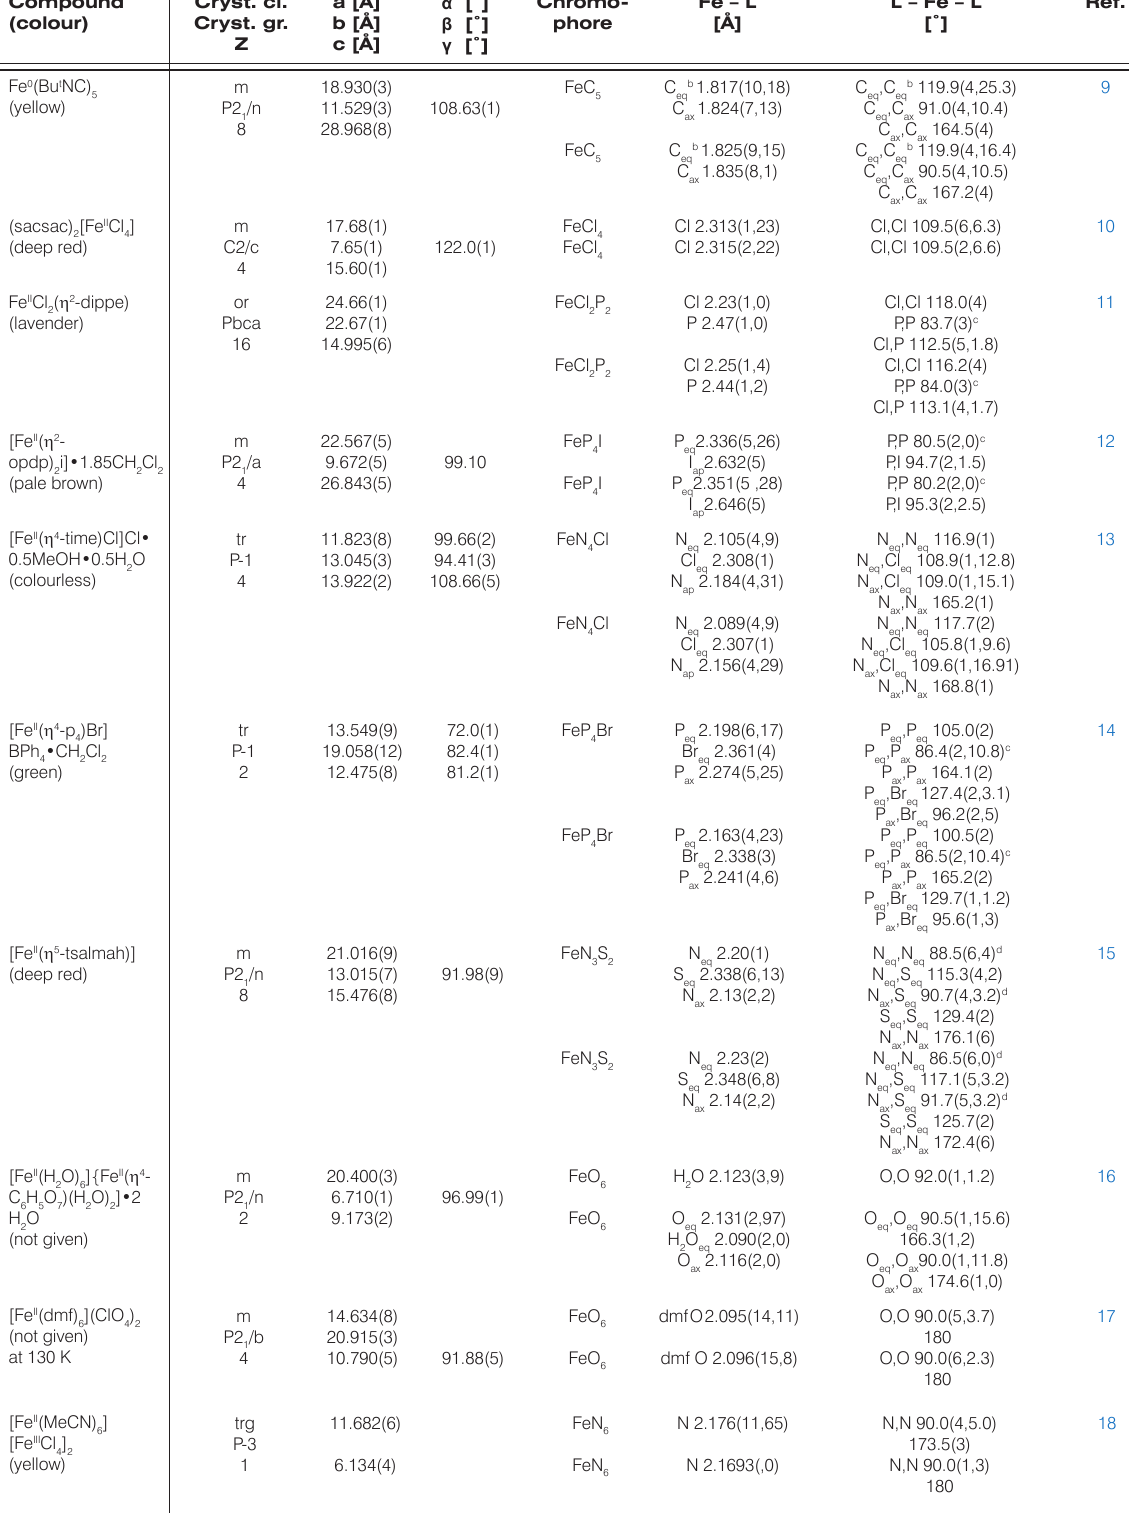
Table 2. Crystallographic and structural data for monomeric iron coordination compounds – crystallographic independent molecules, distortion isomers a Compound Cryst. cl. (colour) Cryst. gr.